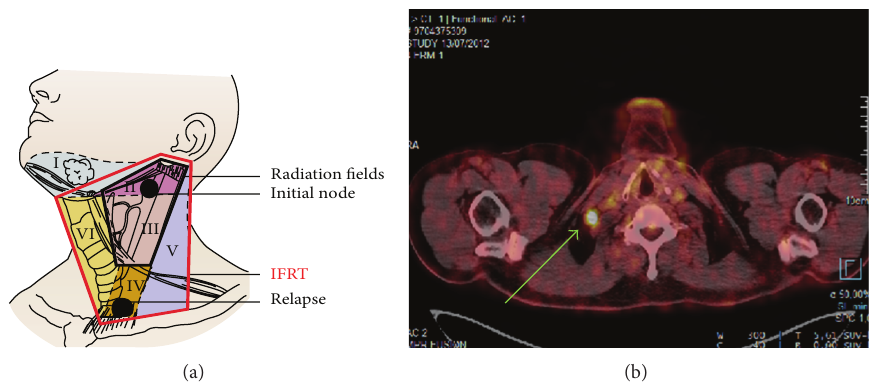
Figure 2: PET scanner showing the relapse in the subclavicular area and mapping.